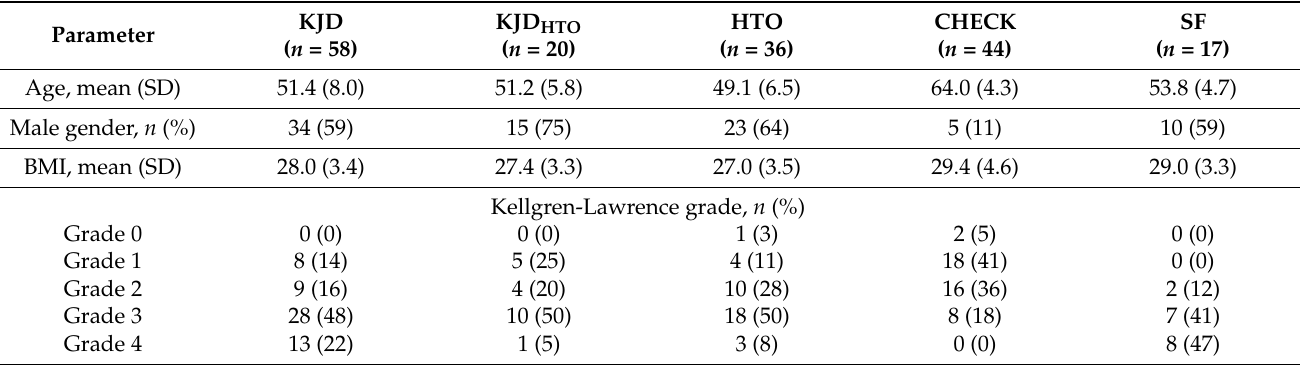
Table 1. Baseline characteristics of the different patient groups.